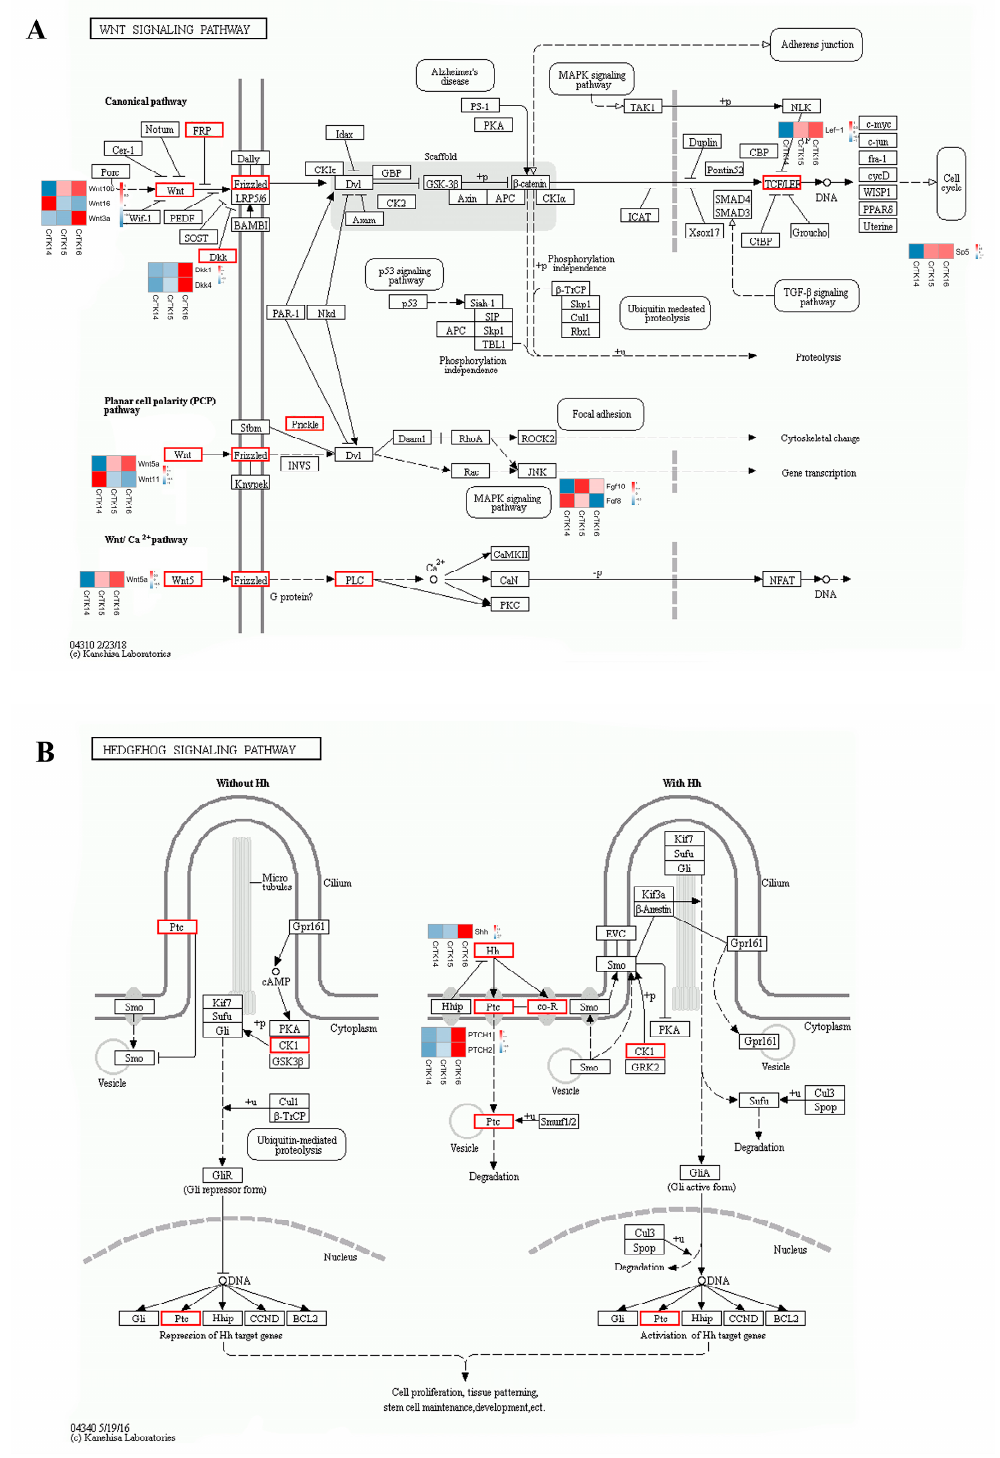
Figure 5. The heat map of the Wnt signaling pathway and the Hedgehog signaling pathway. ( A ) The heat map of the Wnt signaling pathway. ( B ) The heat map of the Hedgehog signaling pathway. The differential expression of genes are marked in red. Heat maps of the genes are shown next to